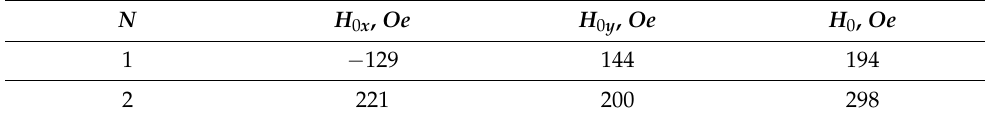
Table 2. For the second stripe with a = 0.3 µ m and b = 0.1 µ